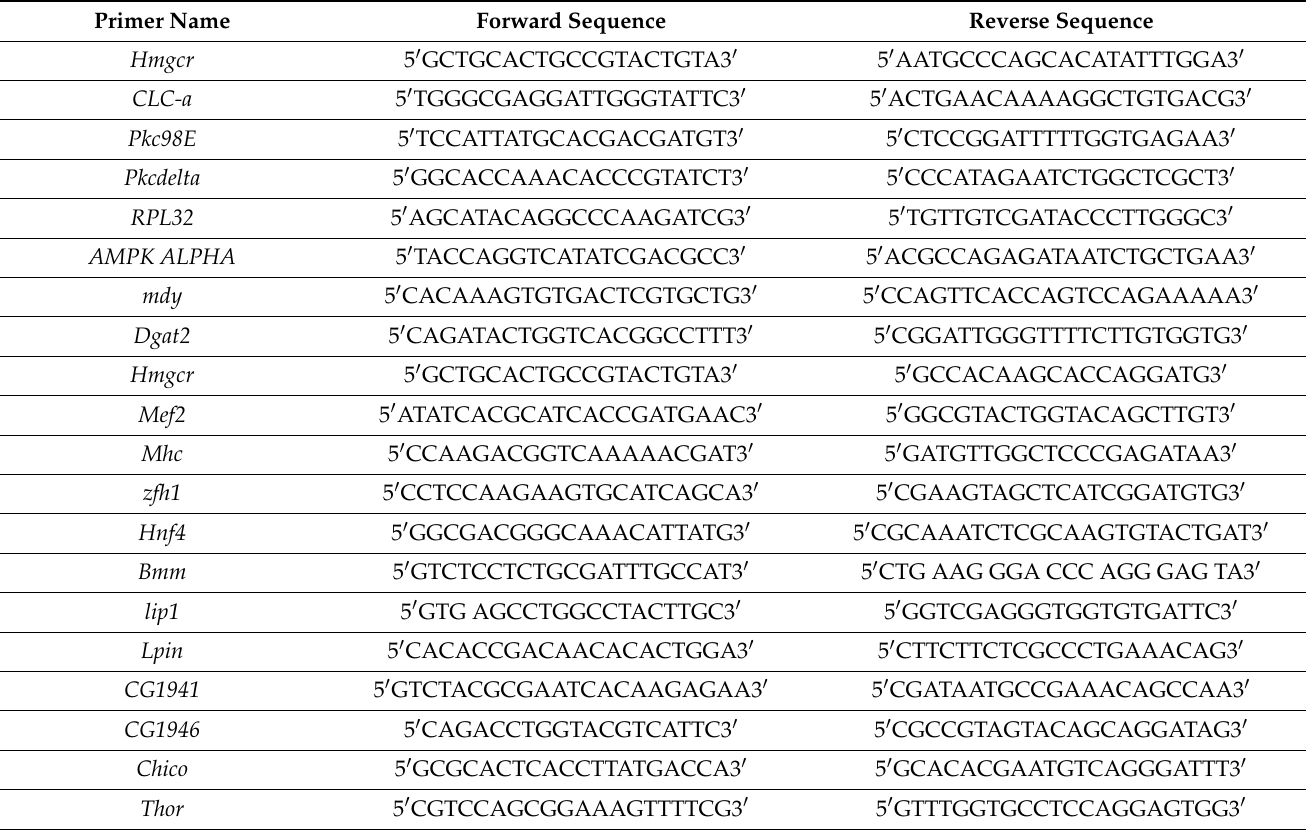
Table 6. Sequences for the primers used in the